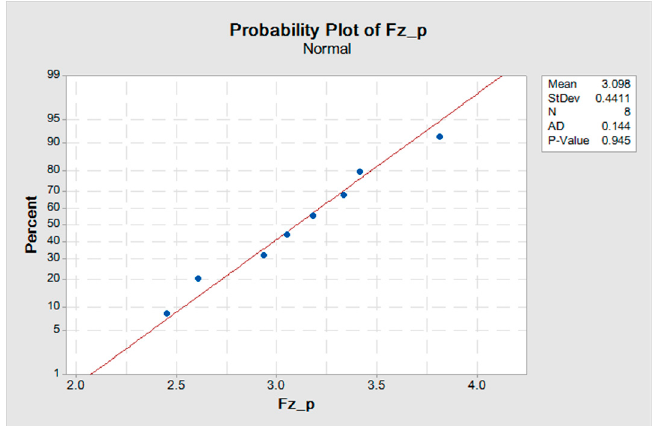
Figure 22. Normal distribution of the F z-p .